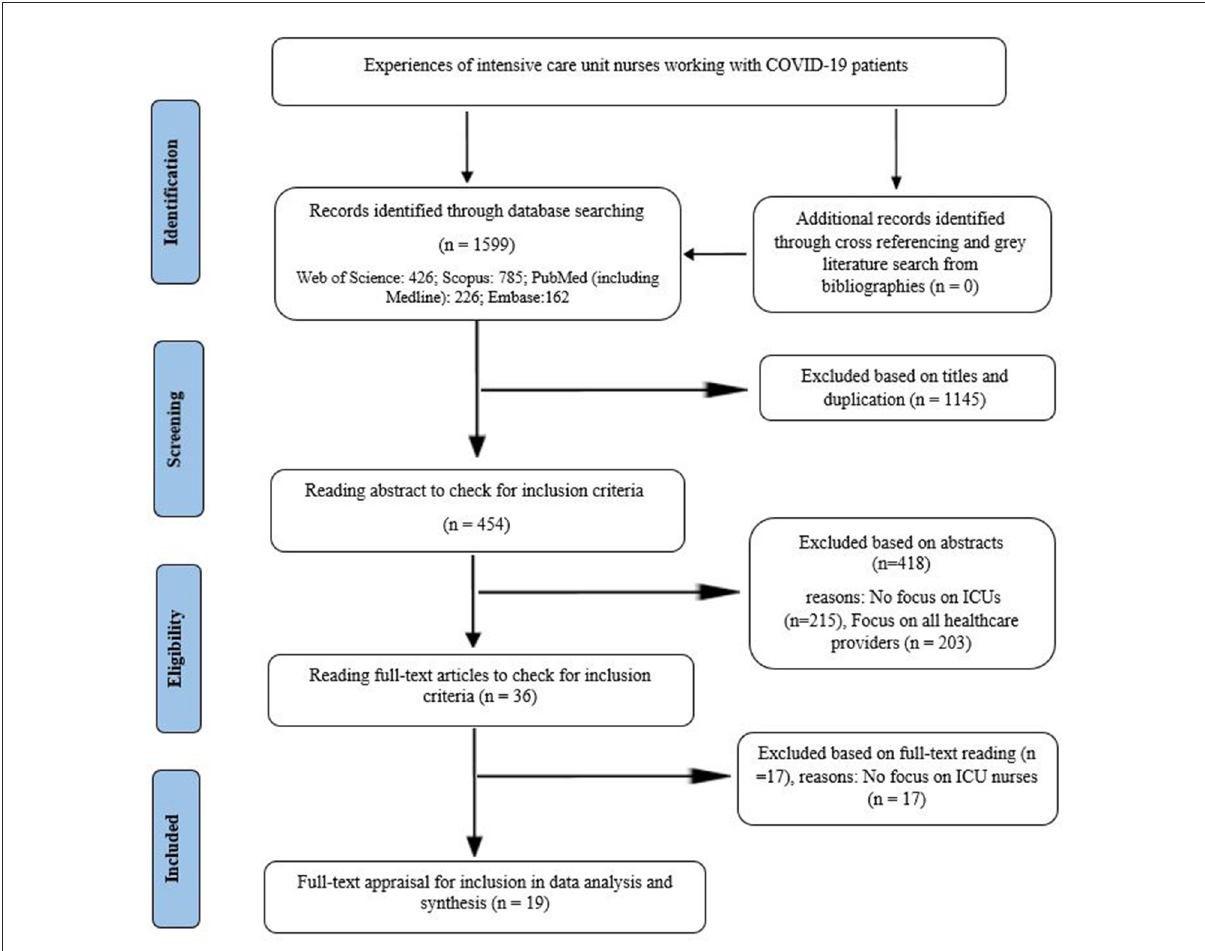
FIGURE1 The preferred reporting items for systematic reviews and meta-analyses